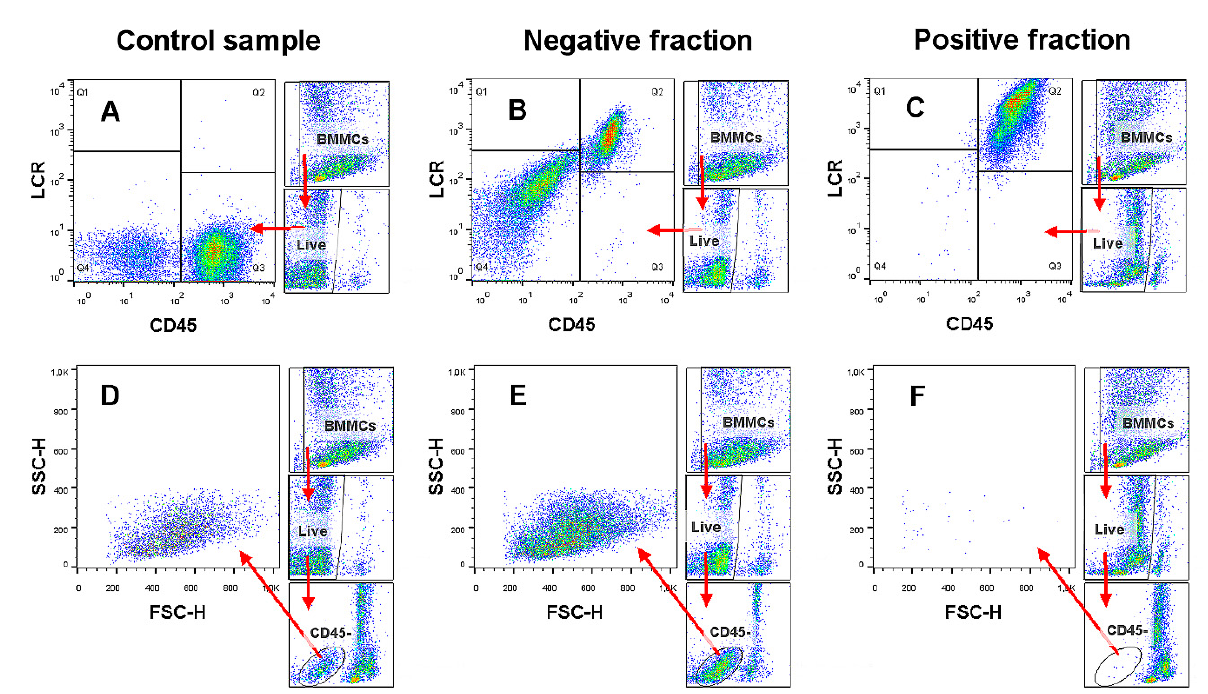
Figure 1. Flow cytometric strategy for the evaluation of magnetic-activated cell sorting (MACS) sorting efficiency. Firstly, live bone marrow mononuclear cells (BMMCs) were gated and then the number of single (CD45 + ) and double (CD45 + LCR + ) positive cells in control unsorted samples ( A ), negative ( B ), or positive ( C ) fractions was measured. Gating on CD45 + cells in control and both fractions ( D , E, and F , respectively) shows the location of CD45 − cells on FSC/SSC dot-plot as well as clear enrichment of these cells in negative fraction compared to control sample or positive fraction. BMMCs—bone marrow mononuclear cells, LCR—labelling check reagent.